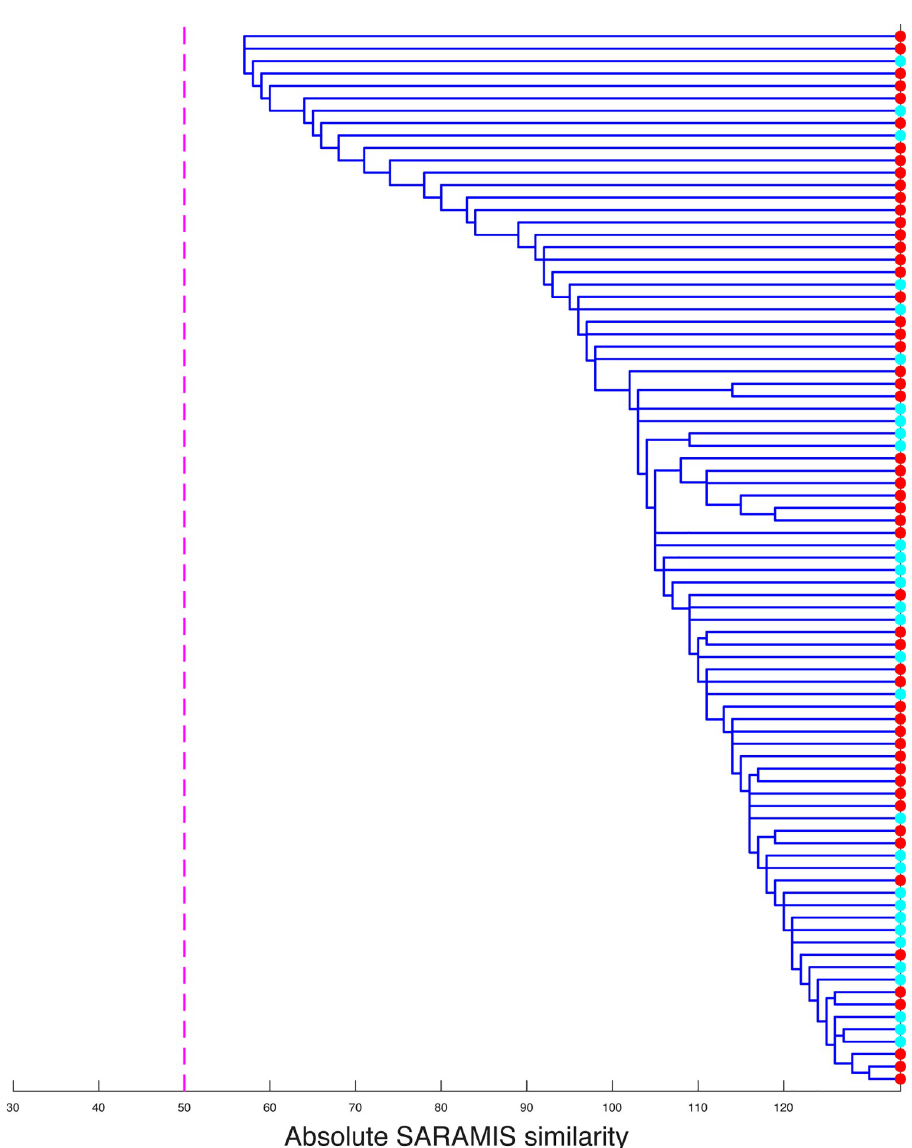
Fig 1. Proximity of B . ceti and B . pinnipedialis MALDI-TOF MS spectra. Cluster analysis, using correlation-based dissimilarity, was performed to assess the discriminating power of MALDI-TOF MS between the spectra corresponding to the species B . ceti (in red) or B . pinnipedialis (in blue). The threshold of 50 common peaks, which is considered as a minimum for considering that spectra are different, is shown as a dotted line.